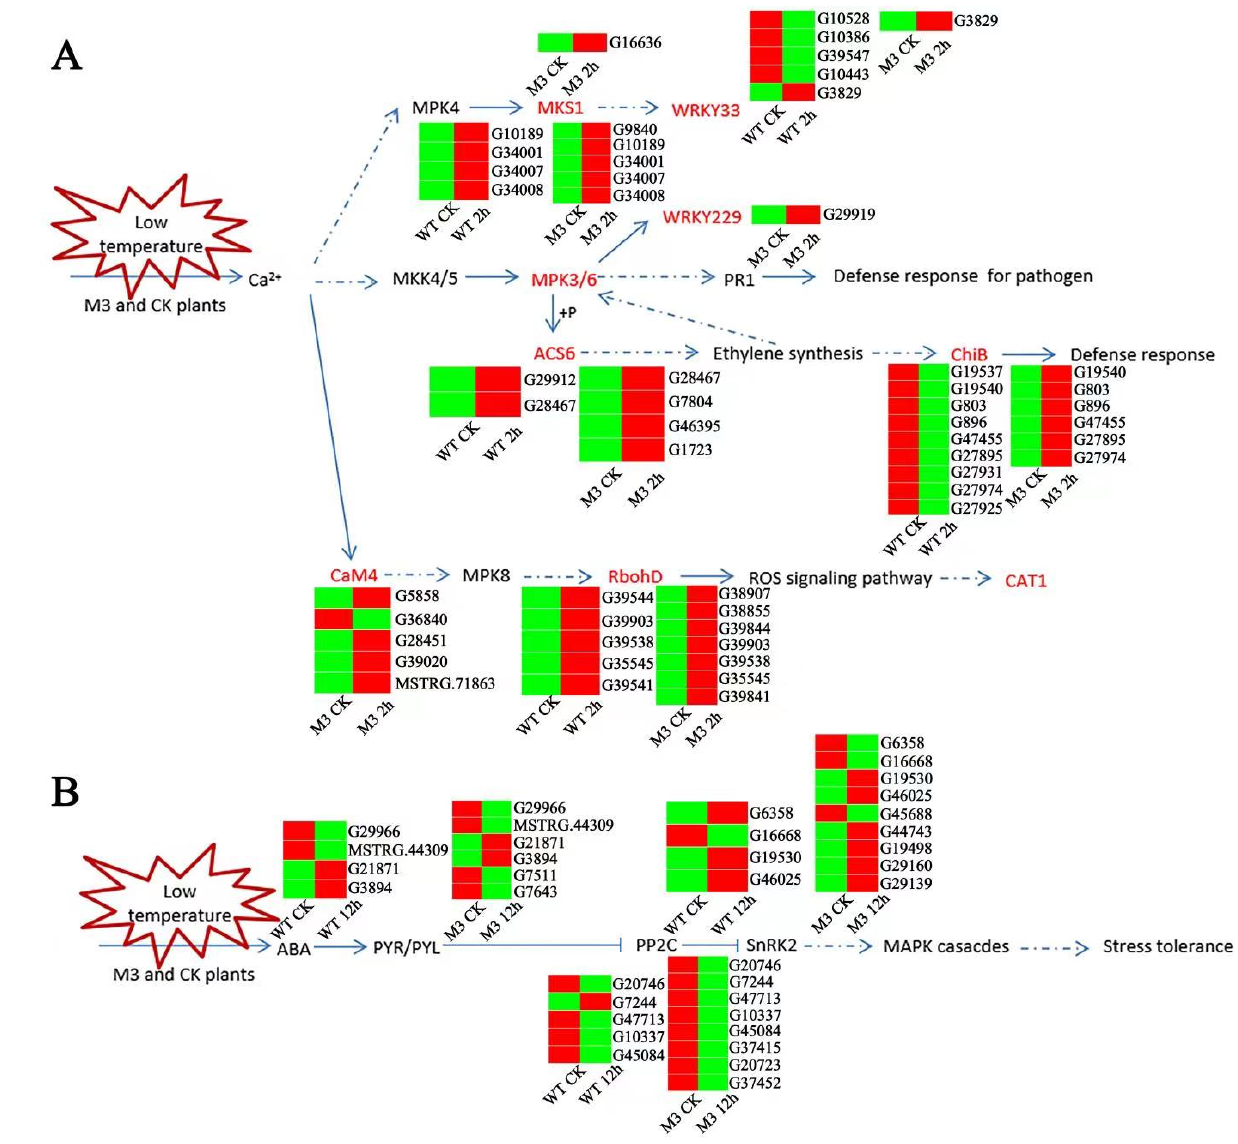
Figure 10. Hypothetical schematic model showing the MAPK pathway and ABA-independent pathway in WT and M3 plants. ( A ) Hypothetical schematic model of MAPK pathway during short-term (CK vs. 2 h) low-temperature stress. ( B ) Hypothetical schematic model of ABA-independent pathway during long-term (CK vs. 12 h) low-temperature stress. An MAPK pathway and ABA-independent pathway model was developed based on the KO enrichment pathway Map04016 and Map04075, respectively. Unique DEGs are shown by heatmap. The red and green color indicated up-regulated and down-regulated expression pattern of genes in heatmap. Blue lines with arrows denote certain regulation, and blue dotted lines with arrows denote uncertain regulation.